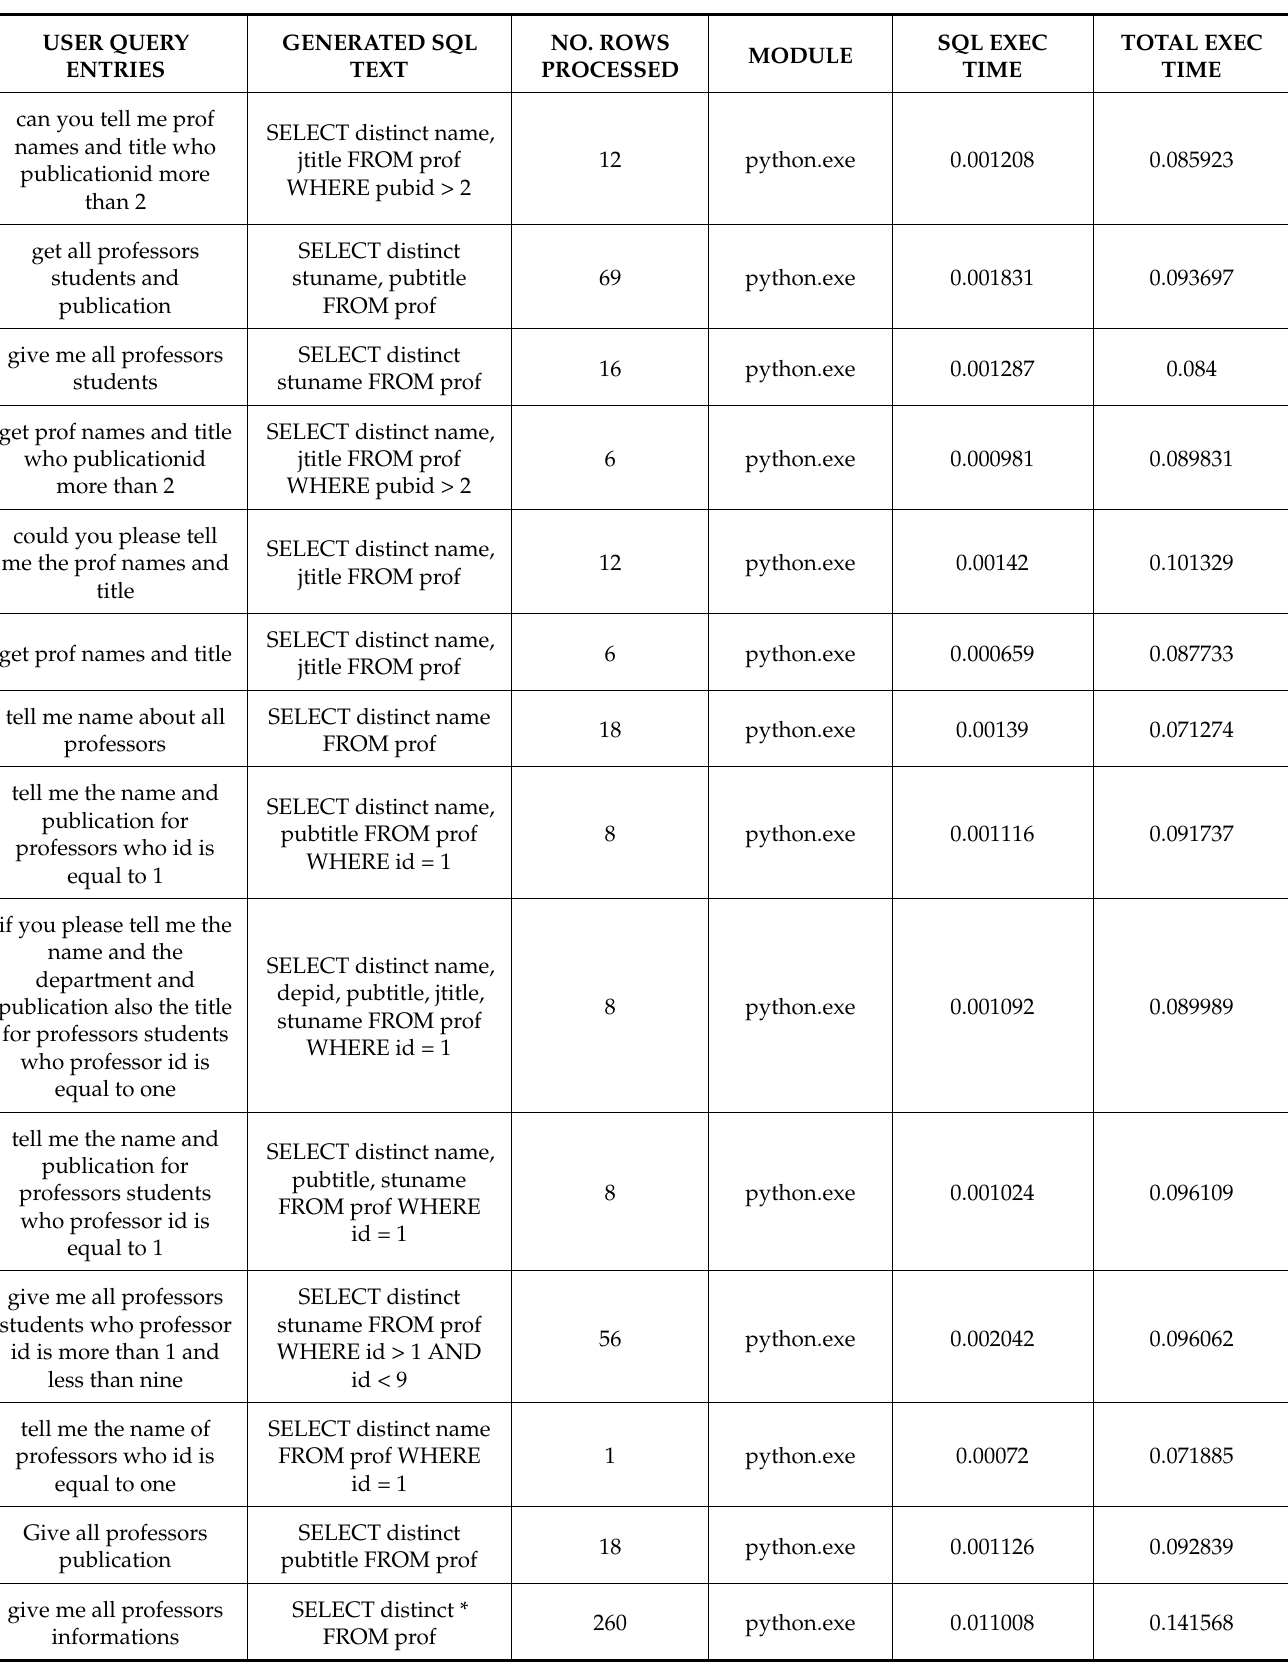
Table 4. NLQ to SQL execution